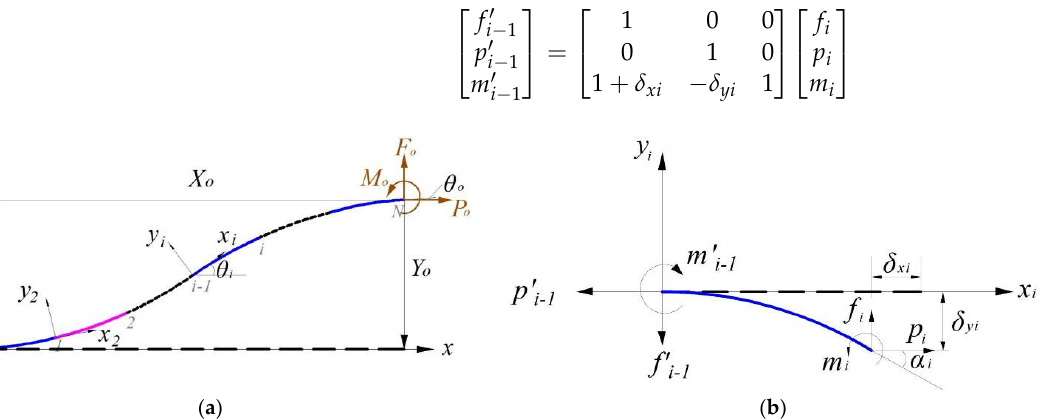
Figure 6. Discretization of the plane’s large deformation beam: ( a ) discretization analysis of the beam; ( b ) i th